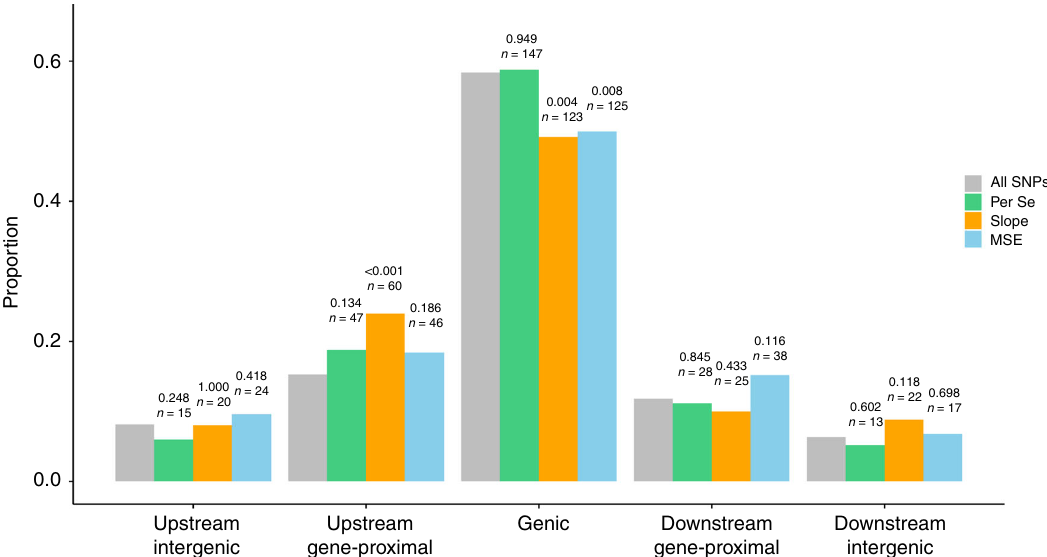
Fig. 5 Patterns of functional variation and classi fi cation of SNPs based on their distance to the nearest gene model. Proportions of 250 slope(type II stability)-associated, 250 MSE(type III stability)-associated, and 250 phenotype per-se-associated SNPs in genic, gene-proximal (0 – 5000 base pairs from nearest gene), and intergenic ( > 5000 base pairs from nearest gene) regions compared to a null distribution of proportions derived from all 413,796 SNPs. Text above each bar indicates sample sizes for each bin and two tailed p -values from an exact binomial test for the null hypothesis of underlying proportion equal to the null distribution. For α ¼ : 05, the Bonferroni multiple testing threshold is α ¼ :